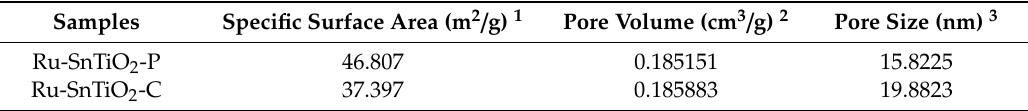
Table 1. Specific surface area and pore properties of two samples.